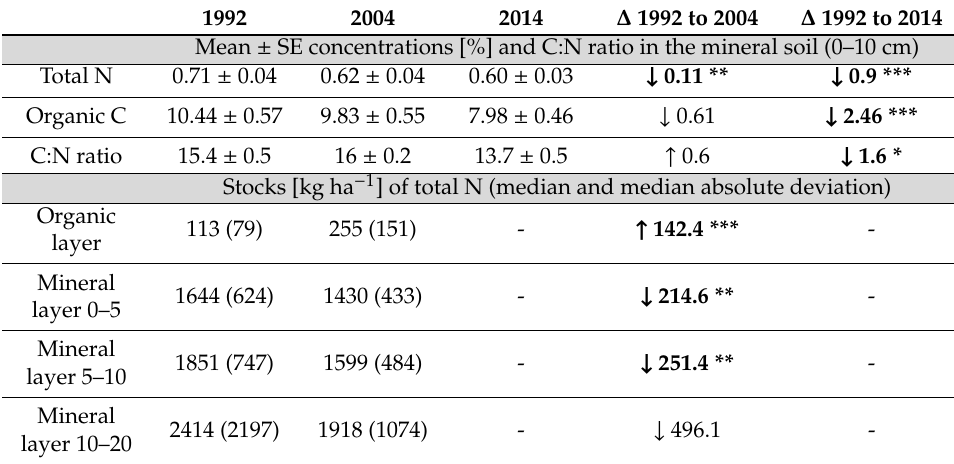
Table 3. Soil total N and organic C content, the C:N ratio, and soil N stocks from resurveys of soil inventories in the years 1992, 2004, and 2014. Statistical significance is indicated with *** p < 0.001; ** p < 0.005; * p <